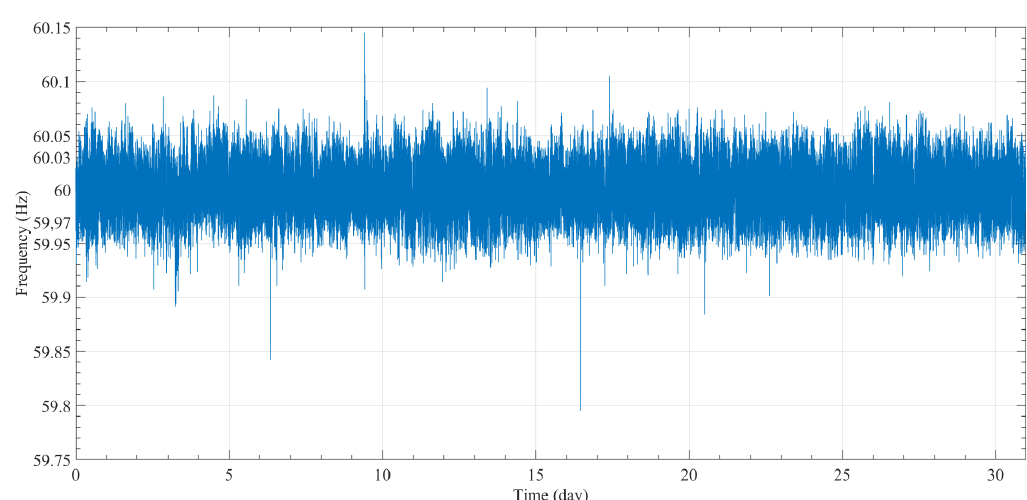
Figure 4. Measured frequency data in Korean power system.